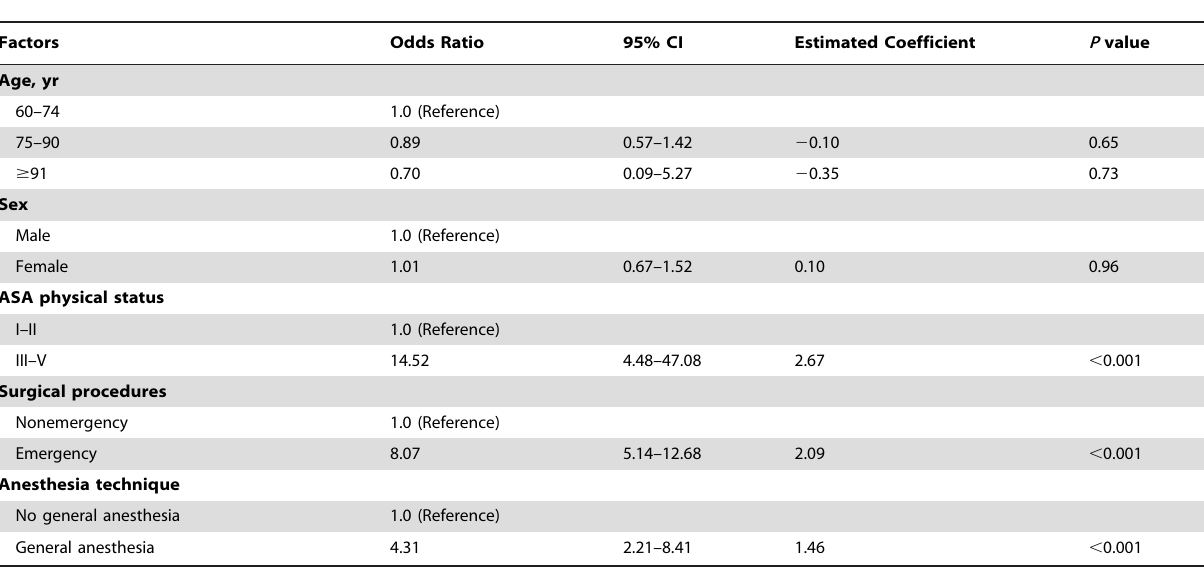
Table 4. Factors associated with intraoperative cardiac arrest in older